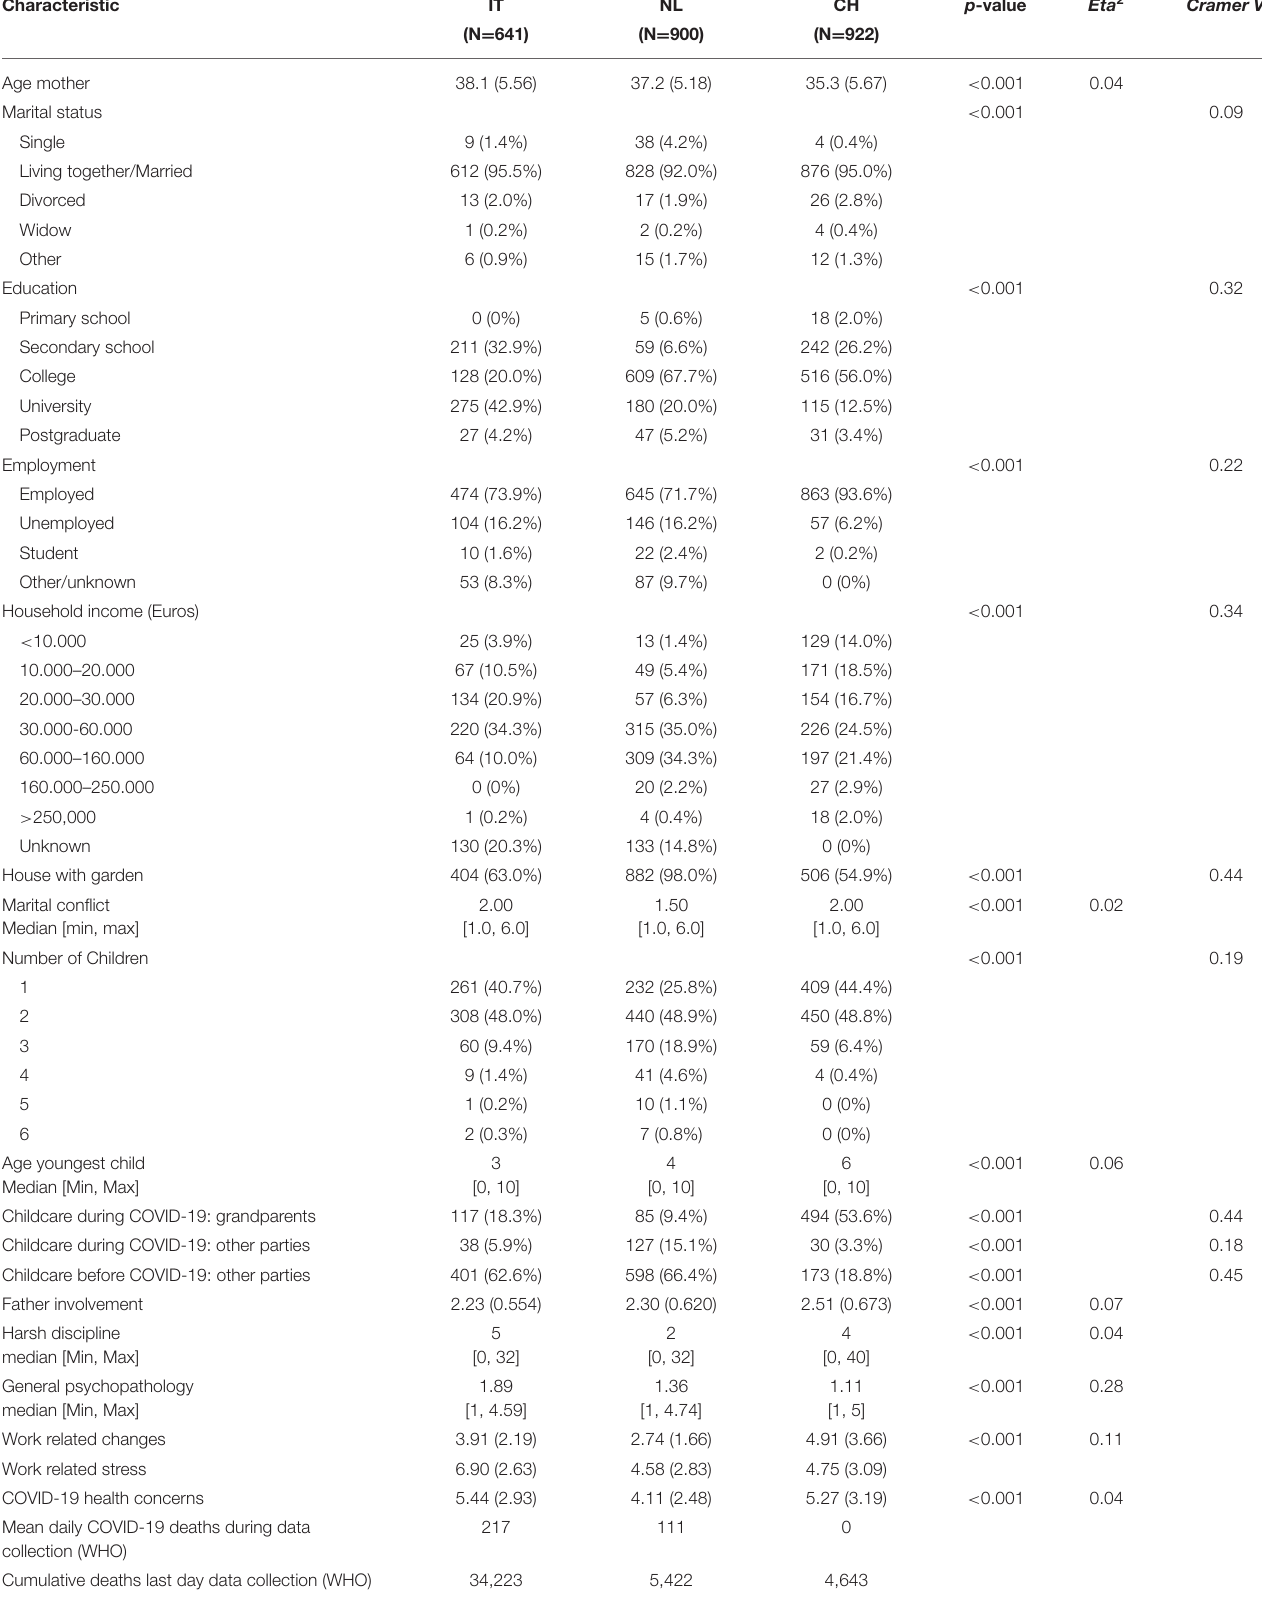
TABLE 1 | Characteristics of Chinese, Italian, and Dutch mothers/families during the COVID-19 pandemic.